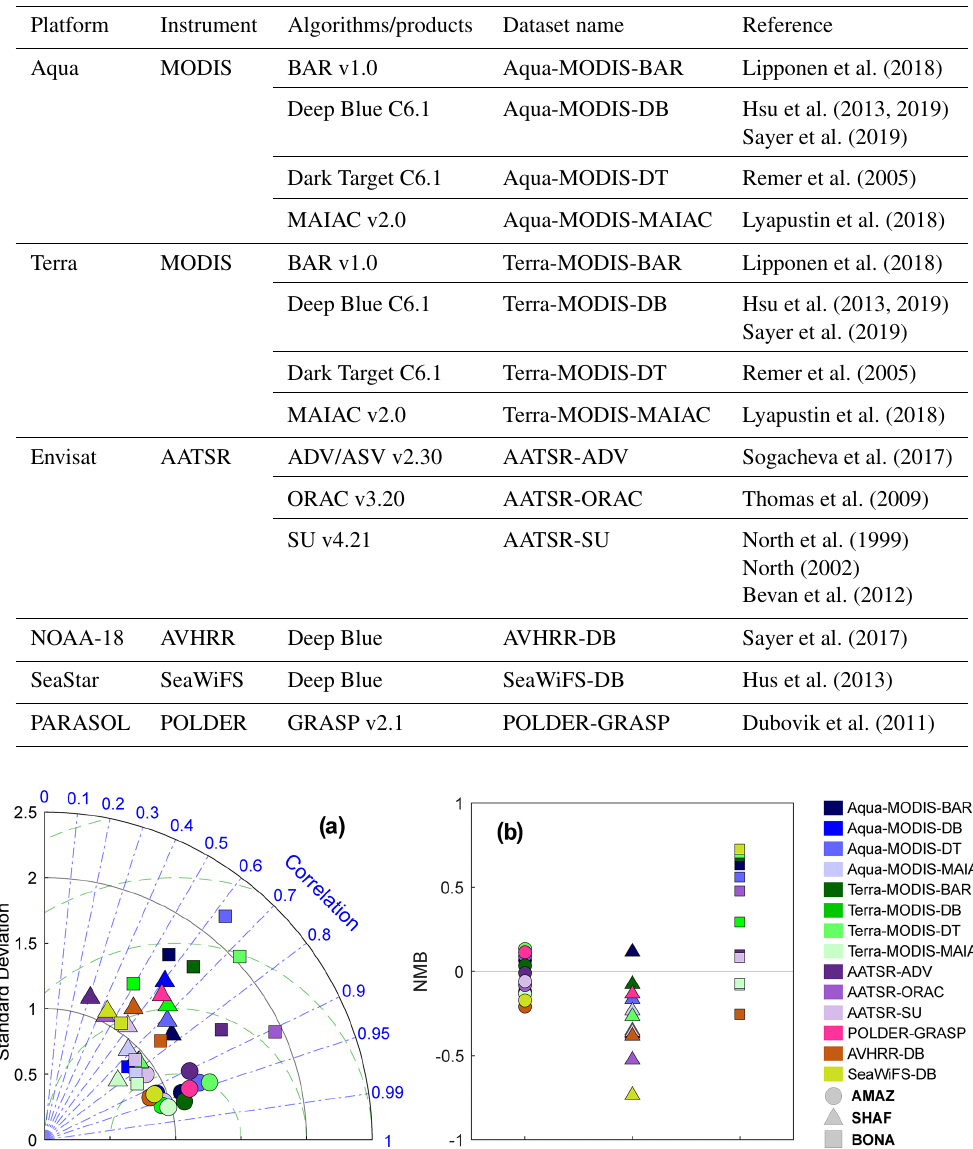
Table 2. Details of the satellite datasets used in this study.